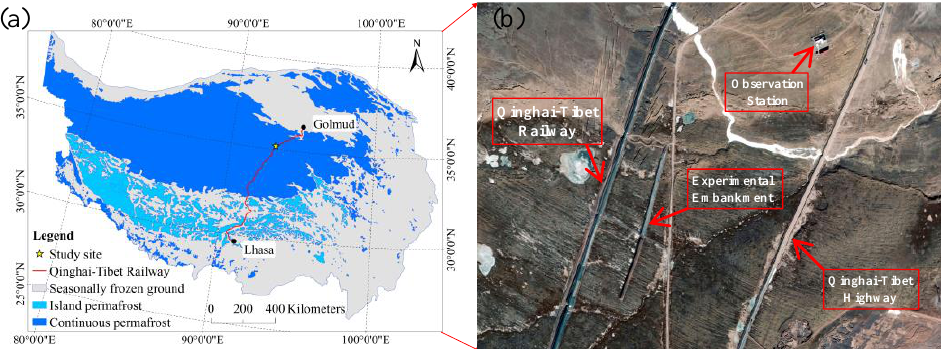
Figure 1. Diagram of the observation site: ( a ) distribution of frozen soil on the Qinghai – Tibet Plateau; and ( b ) location of the experimental embankment on the Qinghai – Tibet Plateau.